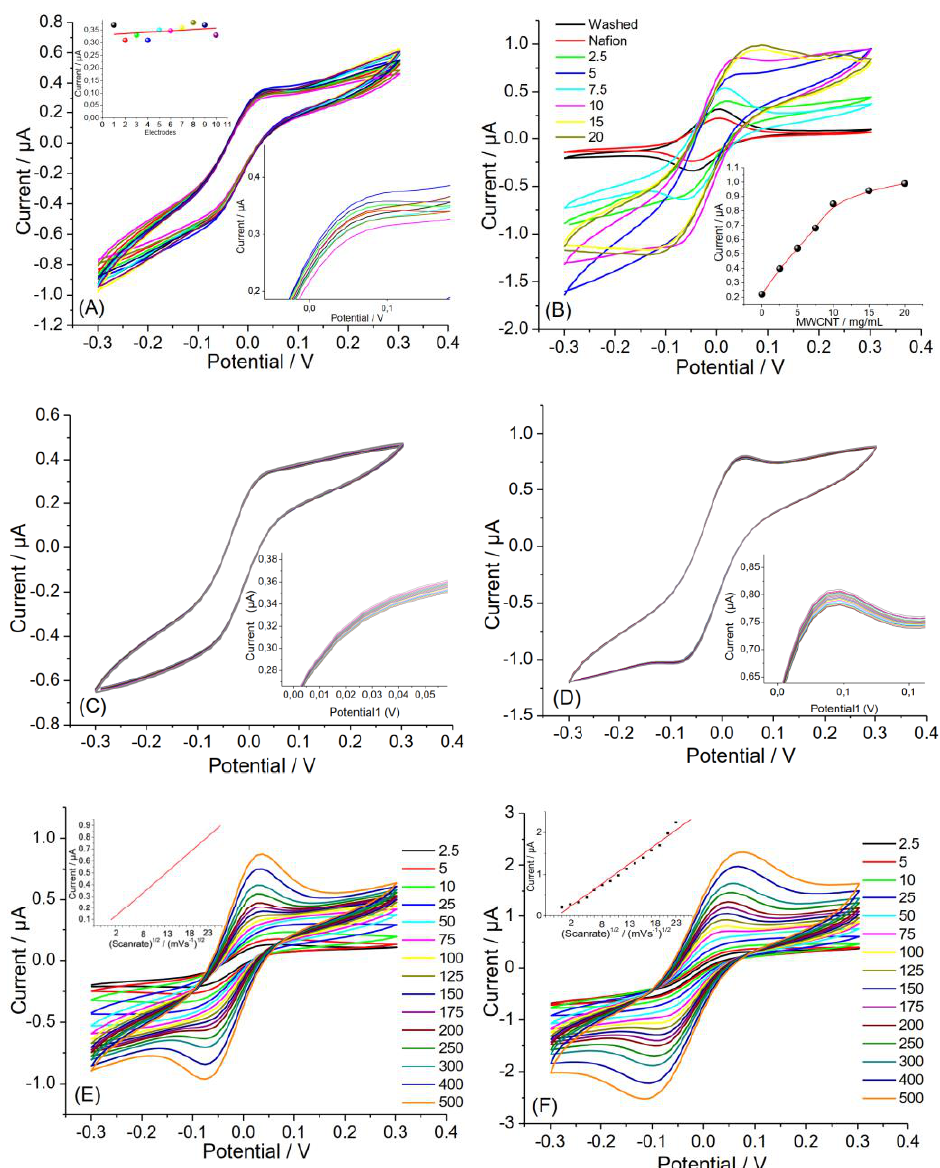
Figure 2. ( A ) CV curves of a randomly selected 10 different washed CTSs (scan rate of 50 mV/s) Inset: number of electrodes vs. sensor response and magnified zone of plot; ( B ) effect of surface modification of CTS with Nafion (Nf) and MWCNT (scan rate of 50 mV/s); repeated CV curves for inset: amount of MWCNT vs. sensor response ( C ) washed and ( D ) Nf/MWNCT-coated CTS (scan rate of 50 mV/s, 20 scans); CV curves of inset: magnified zone of plot ( E ) washed and ( F ) Nf/MWNCT-coated CTS with different scan rates in a solution of 5.0 mM [Fe(CN)6]3 – /4 – /0.1 M KCl.